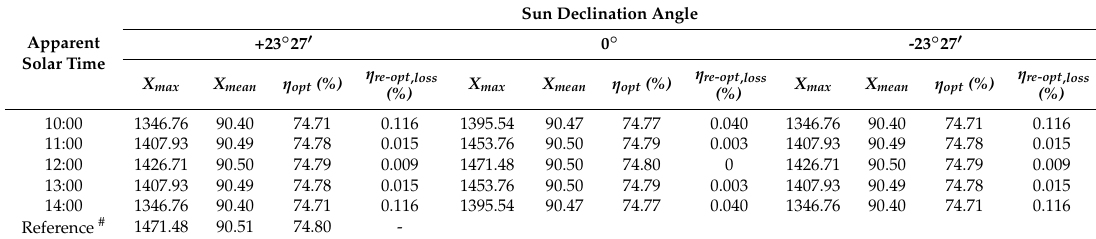
Table 5. Simulation optical characteristics of the fixed-focus Fresnel lens solar concentrator under different incident angles in total